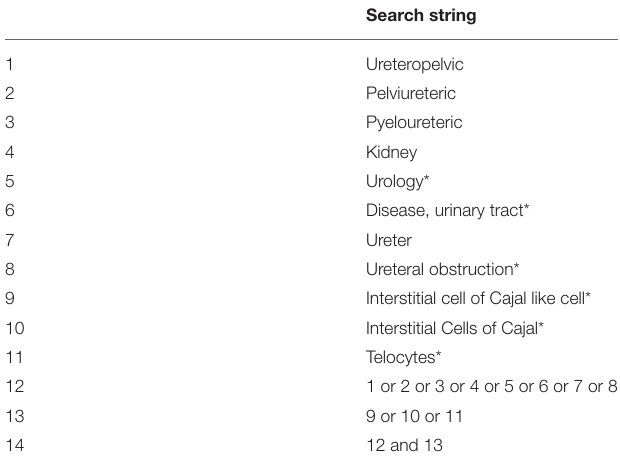
TABLE 1 | The PubMed search